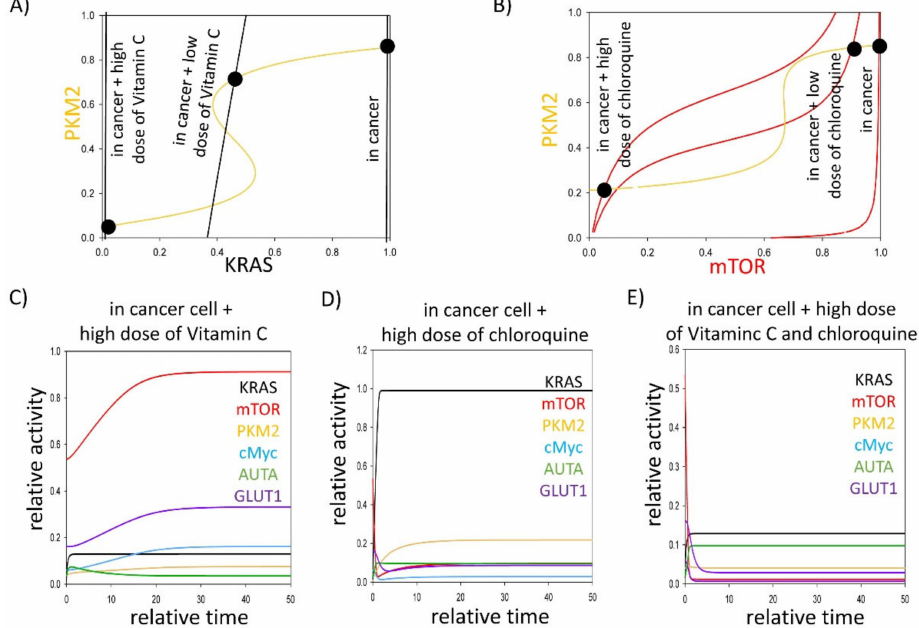
Figure 3. Affecting either KRAS or mTOR pathways might have therapeutic roles in treating cancer cells. The ( A ) PKM2– KRAS and ( B ) PKM2–mTOR signal–response curves are plotted in cancer cells (karas = 1) combined with addition of various doses of ( A ) pharmacologic ascorbate (kiras’ = 1, kiras’ = 1.5) or ( B ) chloroquine (kimr’ = 1, kimr’ = 1.5). Intersections of nullclines represent the stable (filled circle) steady states. The computational simulations are determined in cancer cells (karas = 1) combined with the addition of ( C ) pharmacologic ascorbate (kiras’ = 1.5), or ( D ) during chloroquine treatment (kimr’ = 1.5, AUTAT = 0.1), or ( E ) in a combined treatment of pharmacologic ascorbate and chloroquine (kiras’ = 1.5, kimr’ = 1.5, AUTAT = 0.1). The temporal dynamics are simulated with karas = 1. The relative activity of KRAS, PKM2, mTOR, cMyc, autophagy (AUTA) and GLUT1 is shown. For detailed description of the elements and constants of the theoretical models, see Tables A1 and A2,